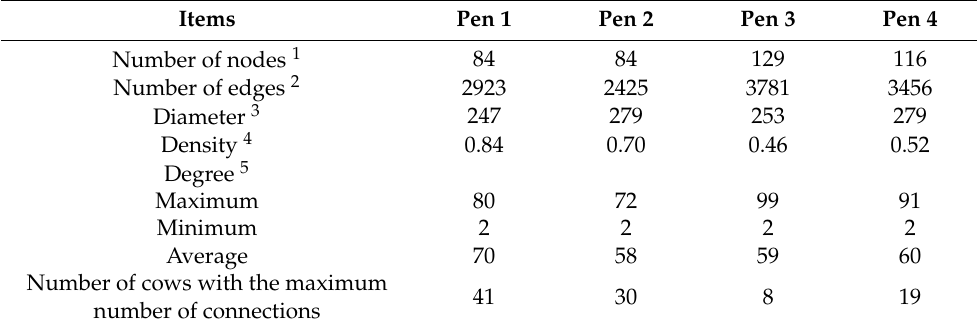
Table 3. Social network metrics of the four pens.